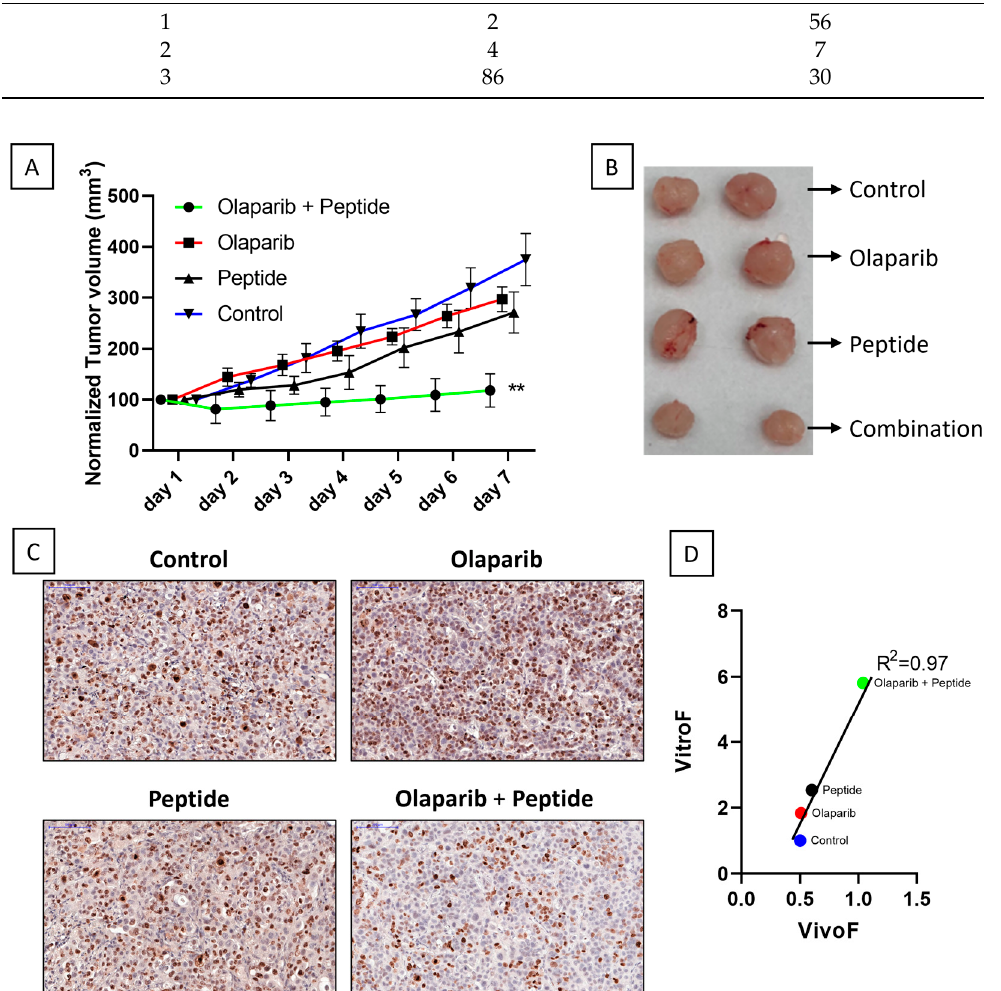
Figure 5. Correlation between in vivo and ex vivo response of Patient #1 to single and combinatorial treatment of therapeutic drug and R11-NLS-Pep8. Xenografts bearing NSG mice were treated with Olaparib, R11-NLS-Pep8, and a combination of both for 7 days. Olaparib was administered daily while R11-NLS-pep8 was administrated thrice in a week. Both the materials were injected intraperitoneally (IP). ( A ) Mean tumor volumes (mm 3 ) normalized to day 1 measurement of each mouse in Control and drug-treated groups are shown in the tumor growth curve. Graphs representing ordinary one-way ANOVA multiple comparisons test, ** p < 0.01, significantly different from control. ( B ) Comparison of the tumor sizes from one representative mouse in each group after final excision. ( C ) Representative IHC images of control and treated explants showing cell proliferation marker, Ki67 post in vivo treatment (20× magnification, 100 µm scale-bar). ( D ) Linear regression plot for the correlation data between VitroF and VivoF for each treatment in Patient #1 (GraphPad 8.0). The statistical significance of the correlation was determined using the correlation coefficient (R 2 = 0.97).